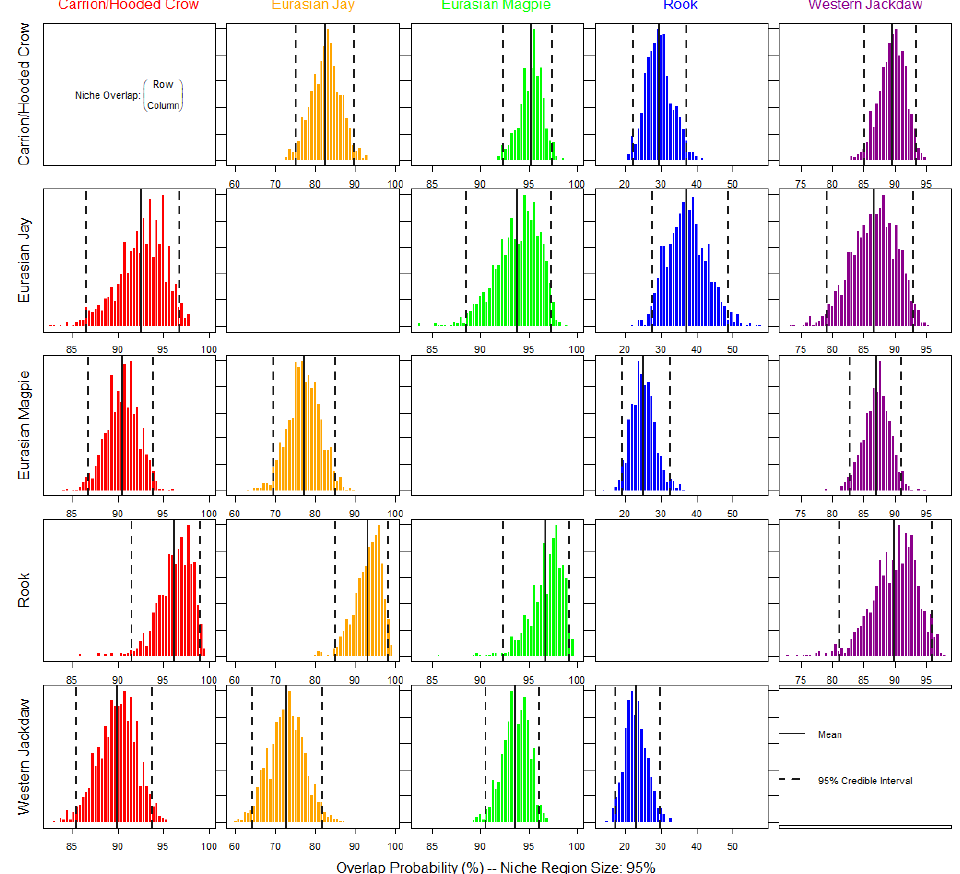
Figure 2. Posterior distribution of the probabilistic niche overlap metric for corvid species in urban areas, considering the land use composition. The posterior mean and 95% credible interval are indicated with black lines and give the probability that species displayed in rows overlap onto those displayed in columns. Table 2. Habitat selection models. Results of the model averaged coefficients of the GLMMs relating corvid species’ presence/absence to urban habitat characteristics. The predictors include the noise and light pollution, the percentage of bare soil, grass, tree, and bush cover, and the number of pedestrians, cats, and dogs present in the 50 m radius around the point counts. The city ( n = 14) was used as a random factor. A separate model was run for each corvid species. For each species, dredging was used to generate all models based on the various combinations of predictors. Models with ∆ AICc < 4 (top models are detailed in Supplementary Table S2.) were averaged to give the results in the table. Estimates with a p -value < 0.05 are in